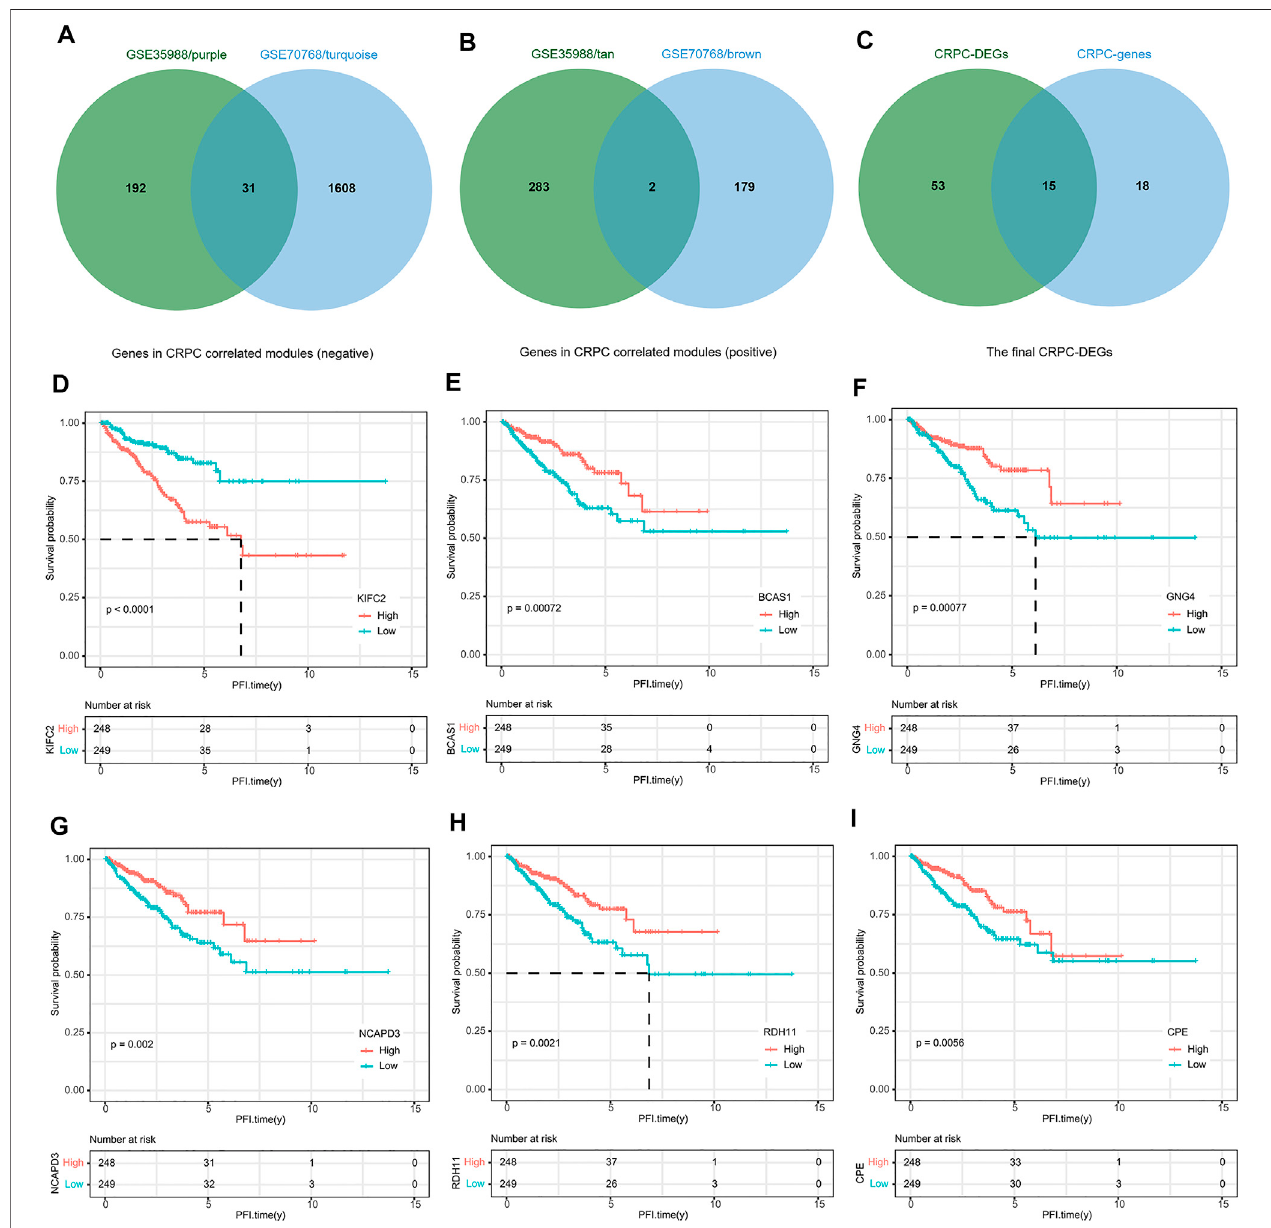
FIGURE8| Identi fi cationofDEGsassociatedwithPFI. (A) VenndiagramofgenesnegativelycorrelatedwithCRPC. (B) Venndiagramofgenespositivelycorrelated with CRPC. (C) Identi fi cation of the fi nal 15 DEGs. (D – I) Representative DEGs signi fi cantly associated with PFI.